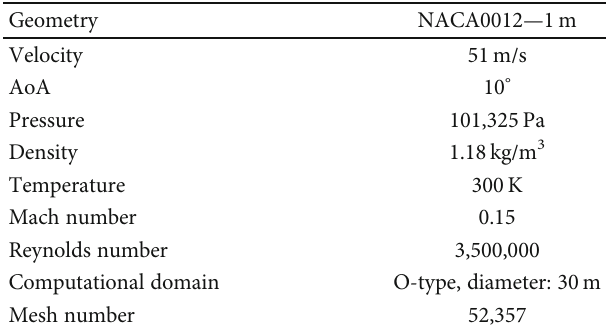
Figure 4: Flow chart depicting the solving strategy of the developed ice accretion solver. Table 1: Setup and inlet conditions of the air fl ow validation case over a 2D NACA0012